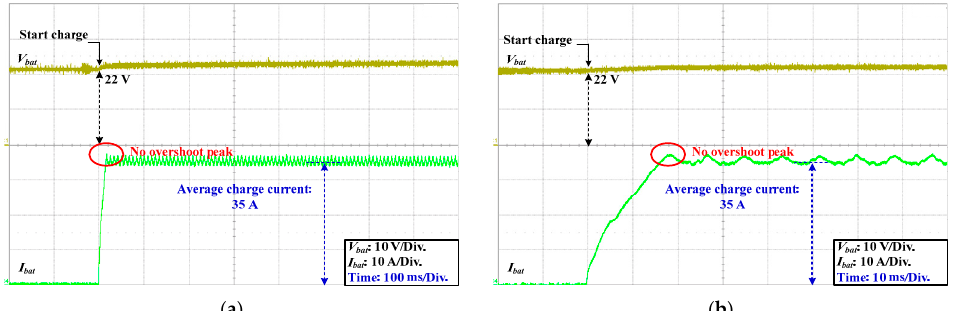
Figure 26. Waveforms of 1C charge using PSPI control. ( a ) Start-charge voltage: 22 V, time scale: 100 ms/div. ( b ) Start-charge voltage: 22 V, time scale: 10 ms/div. Electronics 2018 , 7 , x FOR PEER REVIEW